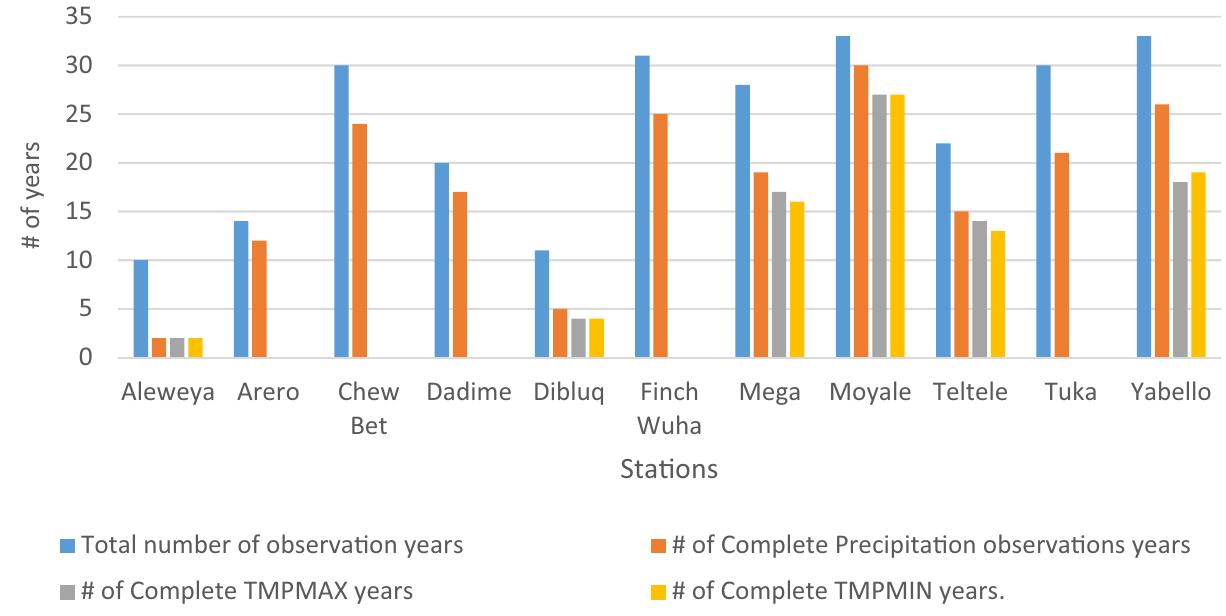
Figure 2. Number of years with complete monthly rainfall/temperature observations compared to the total years of observation by